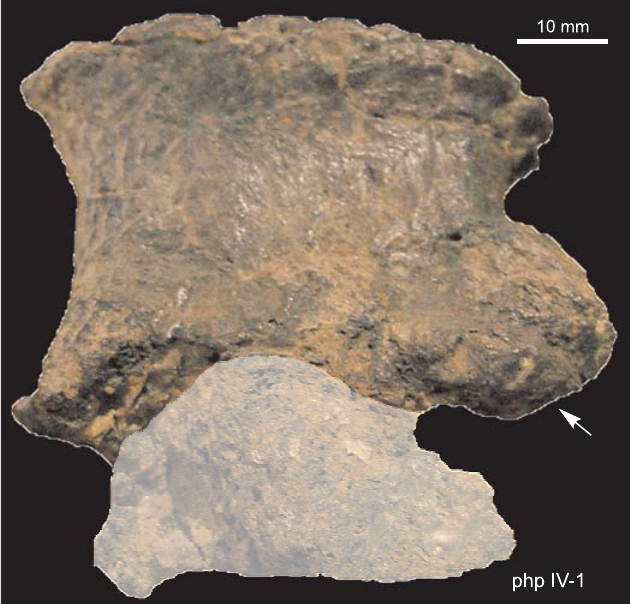
Fig. 9. Overgrowth type 4 (arrow) on the laterodistal corner of the left pedal phalanx IV-1 of the camarasaurid sauropod SMA 0002 from Upper Jurassic Morrison Formation, Howe-Stephens Quarry, Wyoming, USA; in anterior/dorsal view. Abbreviation: php, phalanx of pedal digit. distal medial proximallateral